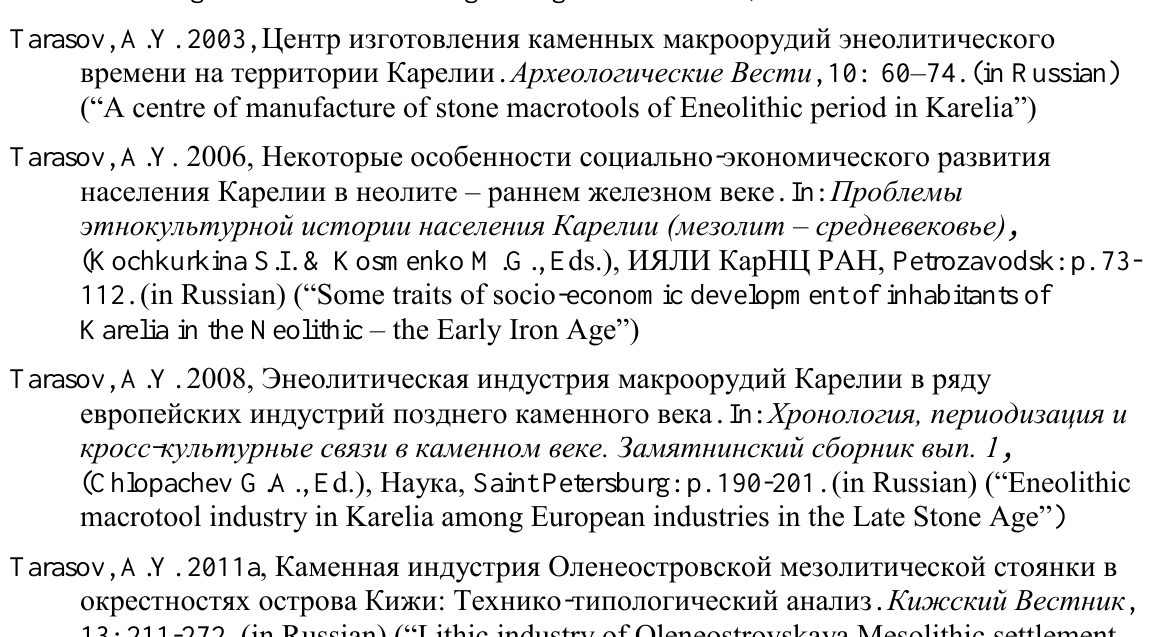
РАН, 4: 56–65. (in Russian) (“Evidences of exchange between inhabitants of Karelian and Estonia in the Final Stone Age: basing on results of archaeological and petrological studies of chopping tools of the Russian Karelian type from the territory of